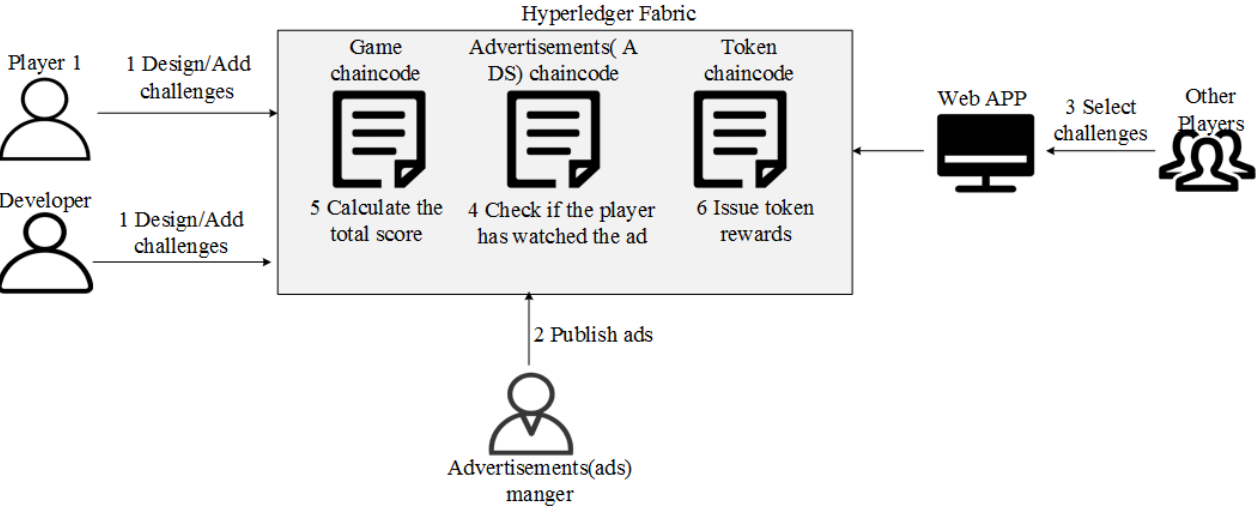
Figure 23. Reconstruction diagram of reference [49].